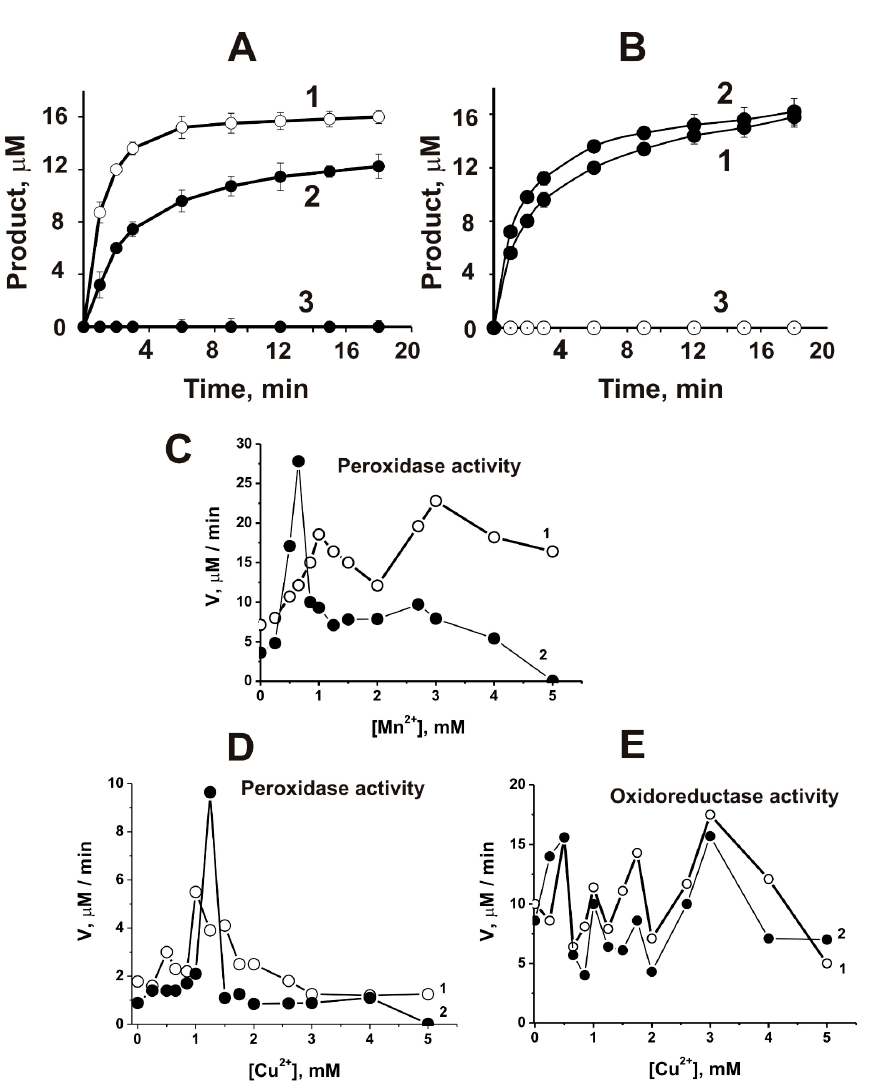
Figure 8. The time-dependences of DAB oxidation in the peroxidase ( A ) and oxidoreductase ( B ) oxidation of the substrate catalyzed by IgG3 before (curve 1) and after (curve 2) its extensive dialysis against 0.1 M EDTA + 0.1 M EGTA and then against 0.3 M EDTA; curve 3, control oxidation of DAB in the absence of Abs. The dependencies of relative peroxidase activity of IgG9 (28 nM) on concen- trations of MnCl 2 ( C ); peroxidase ( D ) and oxidoreductase ( E ) activities of IgG10 (20 and 120 nM, respectively) on the concentration of CuCl 2 . These IgG9 and IgG10 were used before (curve 1) and after (curve 2) their dialysis against EDTA + EGTA [182].